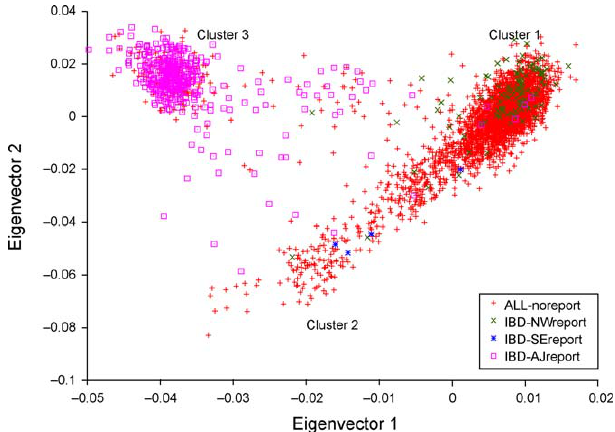
Figure 2. The Top Two Axes of Variation of the Combined Dataset (MS, BD, PD, and IBD) Samples from the IBD dataset are labeled according to self-reported ancestry, as in Figure